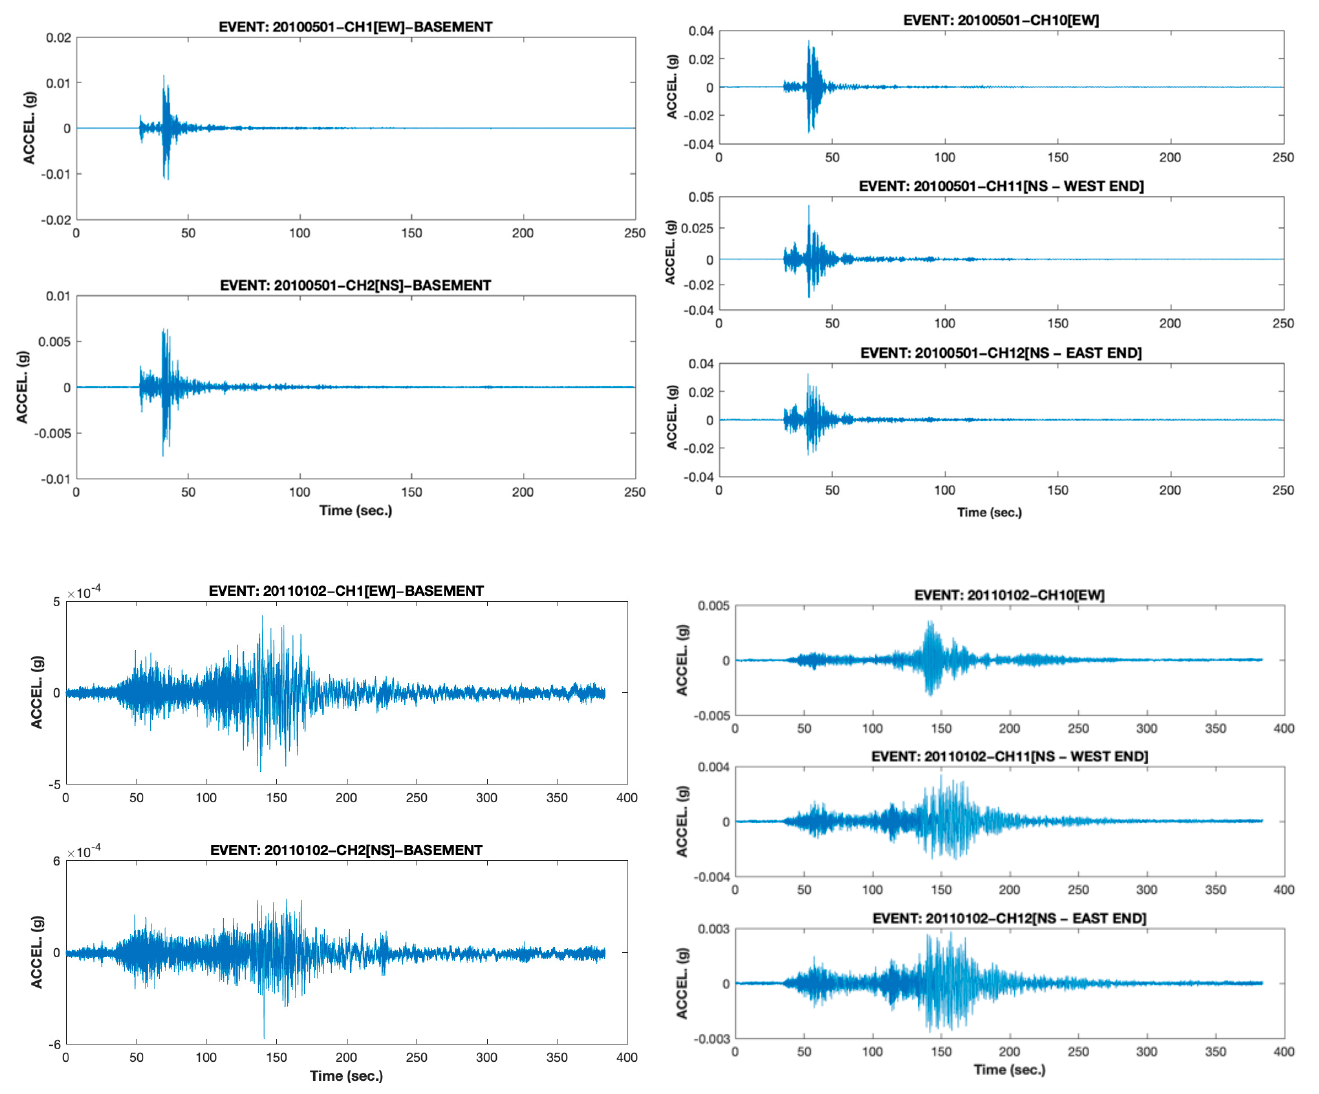
Figure 3. Acceleration time histories recorded at the basement and the roof level of the building on 1 May 2010 ( Top ) and on 2 January 2011 ( Bottom